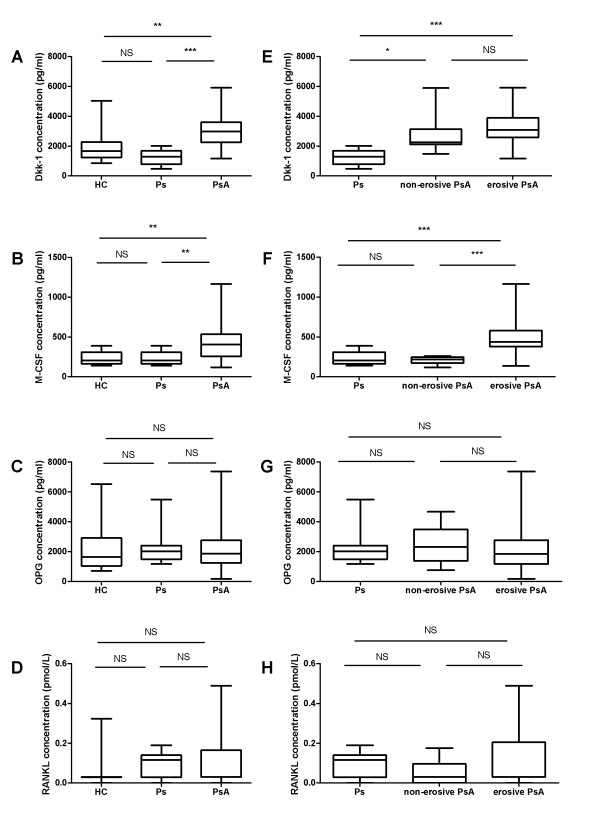
Soluble mediators of bone remodeling in the circulation of patients with PsA. Box-and-whisker plots showing concentrations of (a) Dkk-1, (b) M-CSF, (c) OPG, and (d) RANKL in healthy controls (HCs), patients with psoriasis (Ps) and patients with PsA. Box-and-whisker plots showing concentrations of (e) Dkk-1, (f) M-CSF, (g) OPG, and (h) RANKL in patients with psoriasis (Ps) and patients with nonerosive PsA, and patients with erosive PsA. Median values for RANKL for the healthy control, all PsA, and erosive PsA groups were 0.031 pmol/L. *P < 0.05; **P < 0.01; ***P < 0.001; one-way ANOVA with Dunn's multiple comparison test.